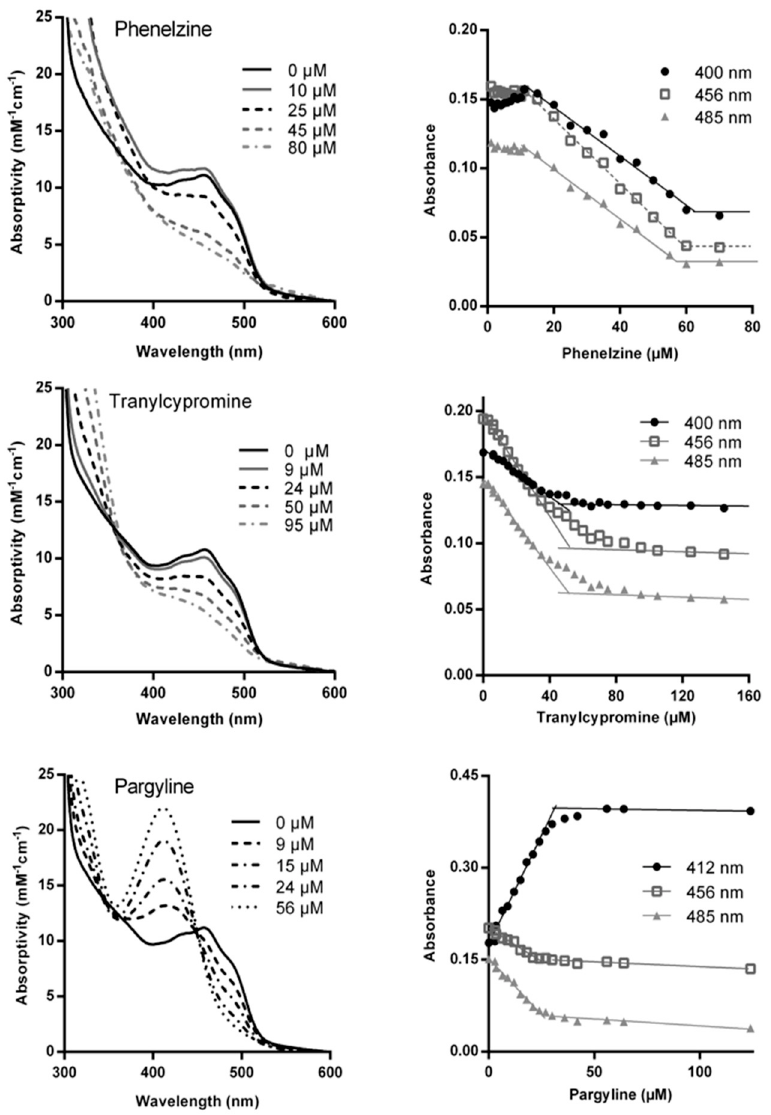
Figure 6. Spectral changes in MAO-A associated with adduct formation. Left , selected spectra (plotted as the absorbance of MAO-A at 1 mM in 50 mM potassium phosphate pH 7.5) during the titration; inhibitor (2 µ L in water) was added to 400 µ L MAO-A and incubated at 20 ◦ C for 15 min before recording each spectrum. Right , absorbance changes at selected wavelengths.